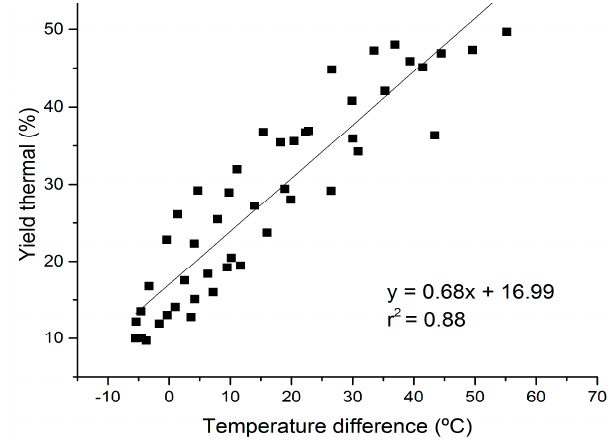
Figure 7. Linear regression curve of the thermal yield has a positive slope.